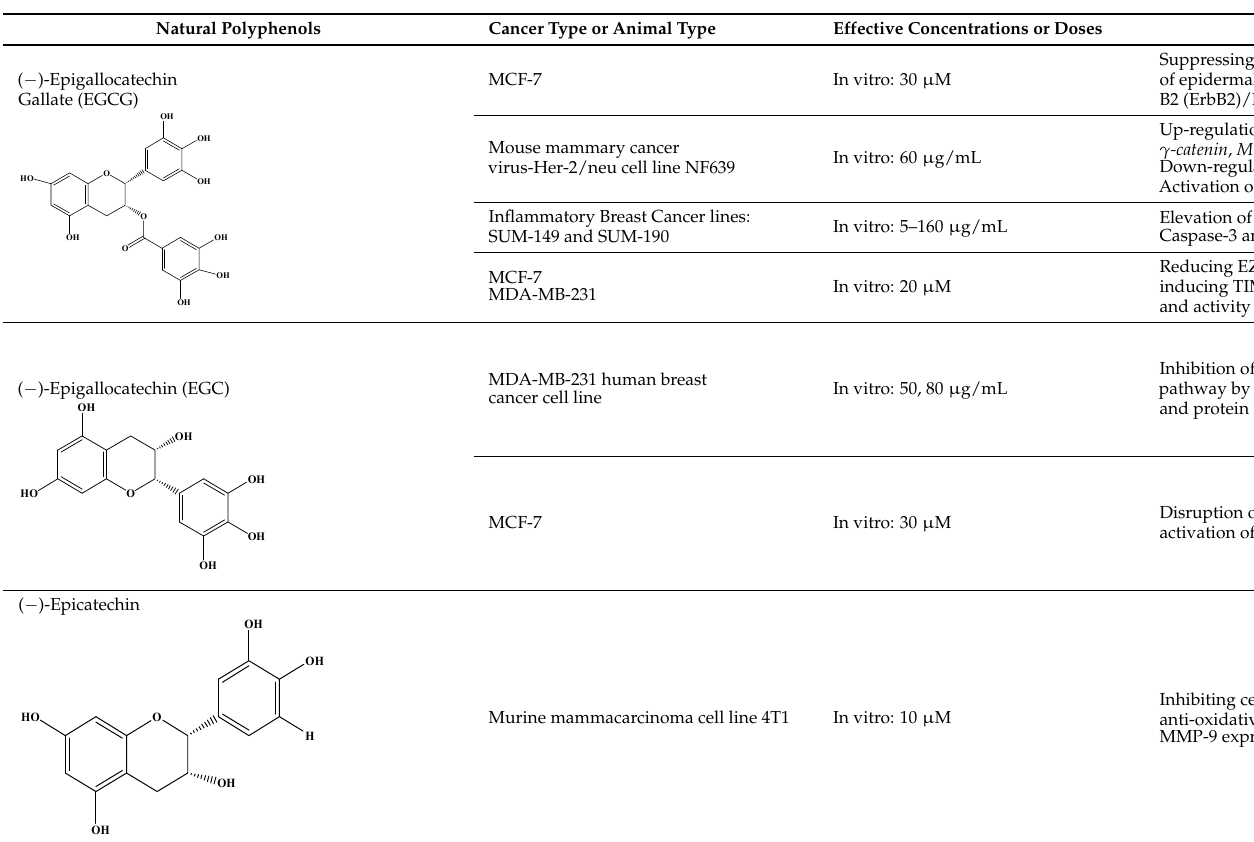
Table 1. Mechanisms of natural polyphenols interfering in breast cancer metastasis.